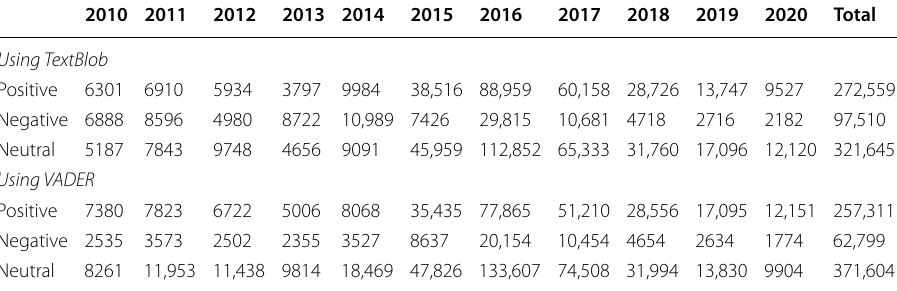
Table 6 The polarity frequency of the tweets over the years